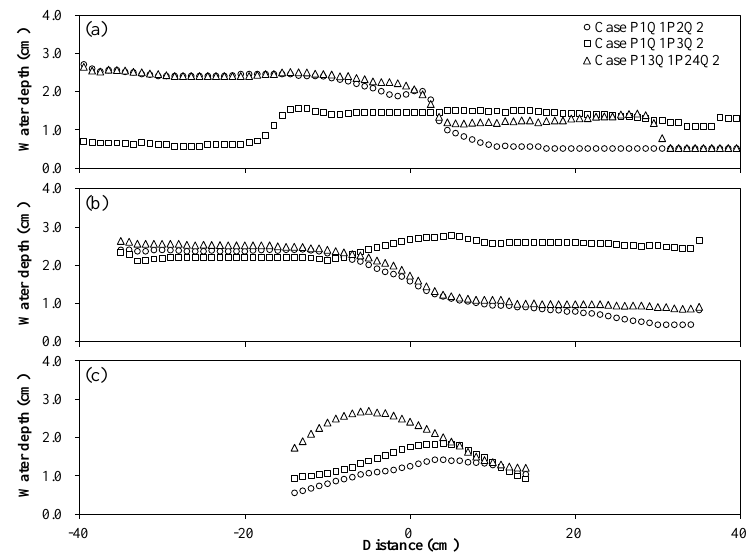
Figure 11. Inundation depth changes with non-uniform inflows: ( a ) Sec. A; ( b ) Sec. B; ( c ) Sec. C.